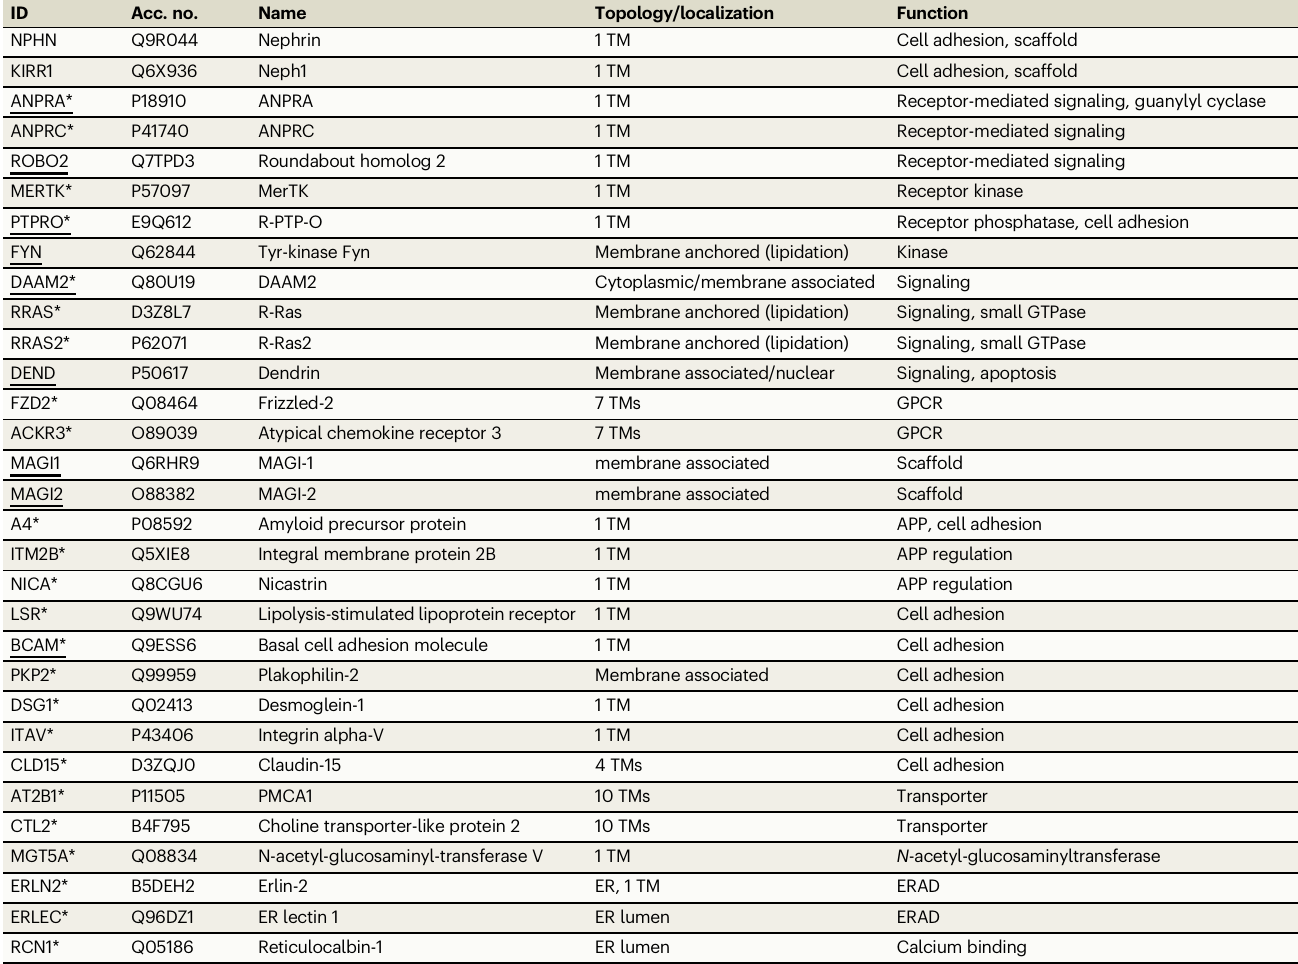
Table 1 | Constituents of the Nephrin/Neph1 interactome determined by meAP-MS, together with annotation of subcellular localization and primary function(s) indicated in literature and public databases ID Acc.